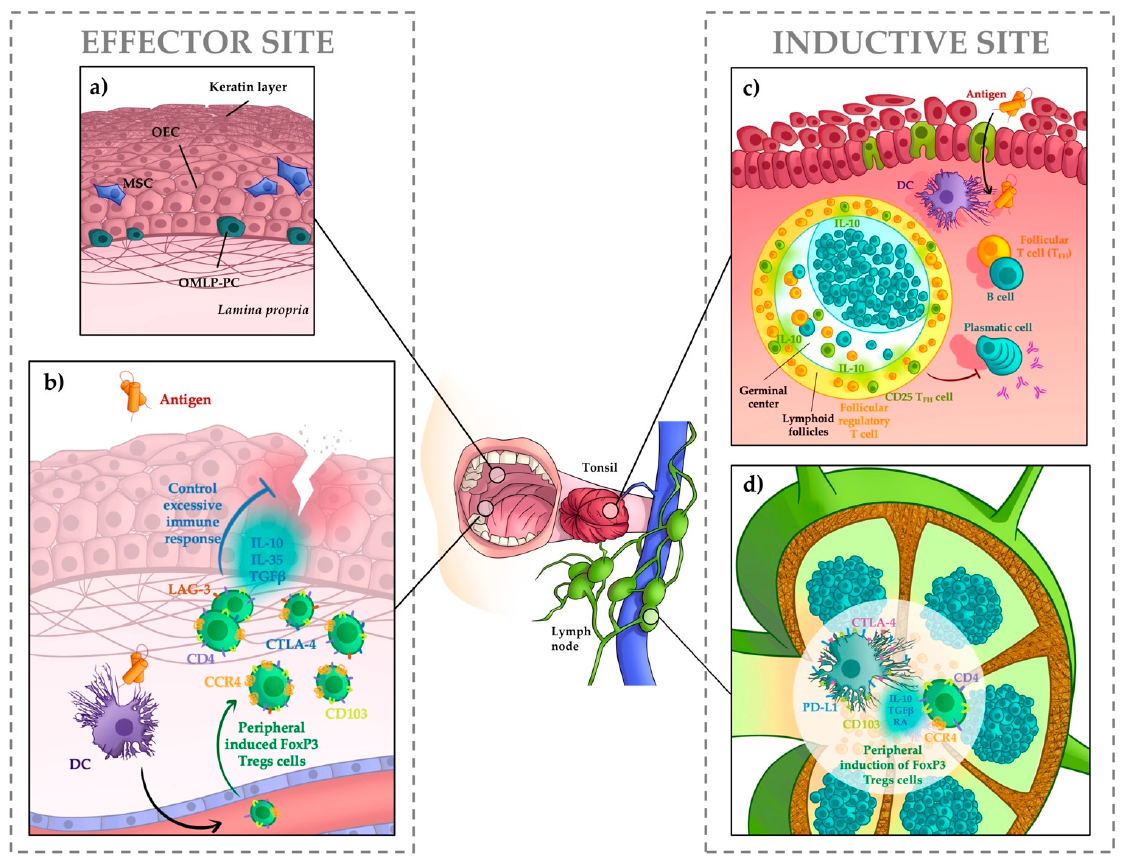
Figure 1. The oral mucosa and associated lymphoid structures. The oral mucosa is lined by stratified squamous epithelia of varying thickness that can be topped by a keratin layer. Some areas related with mastication ( a ) are thick and highly keratinized, while other zones, such as the lining mucosa ( b ), are thinner and feature no keratin layer. Oral epithelial cells (OECs) are derived from local progenitor cells such as oral mucosal lamina propria-progenitor cells (OMLP-PCs). Resident mesenchymal stem cells (MSC) can also differentiate to epithelial cells as well as many other cell types. Resident dendritic cells (DC) can capture these antigens and migrate to secondary lymphoid tissues, including the tonsils ( c ) and proximal lymph nodes ( d ), where adaptive immune responses are elicited (inductive sites). CD103 + CCR4 + Tregs are induced in draining secondary lymphoid tissues ( d ) and migrate to the effector site, where they suppress immune responses when needed via CTLA-4 and LAG-3 expression and IL-10 and TGF β production ( b ). The tonsils are exposed to a constant bombardment of antigens from innocuous sources, such as food, that need to be tolerated. Regulatory follicular T cells (T FR ) as well as CD25 + T FH cells also control GC size and class switching by releasing IL-10 ( c ).